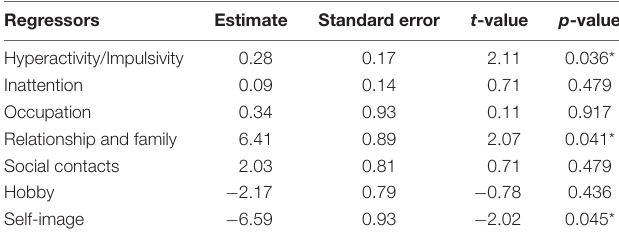
TABLE 5 | Associations of clinical measures with reactive